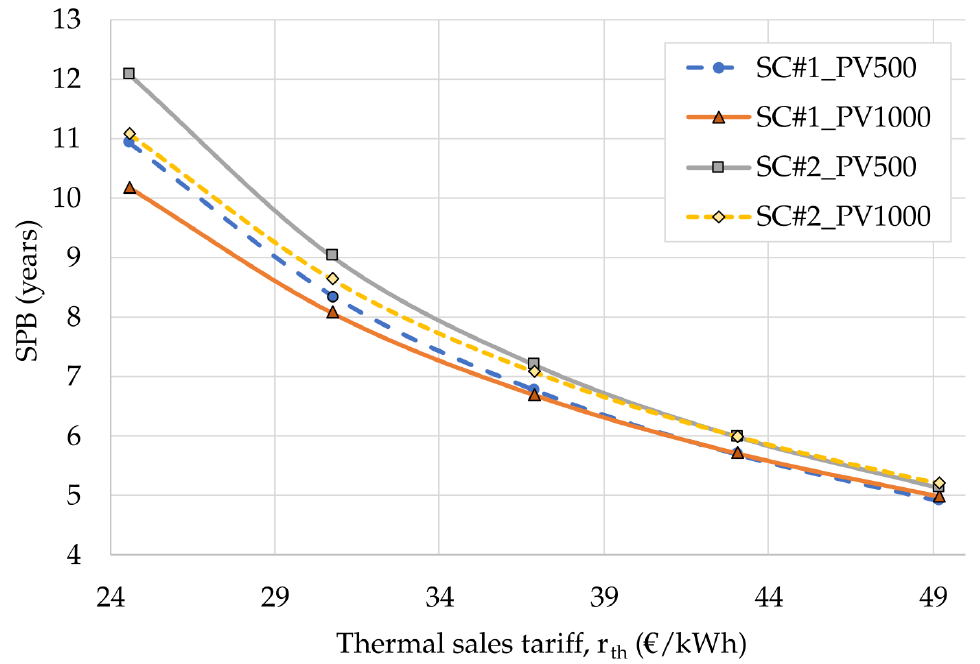
Figure 12. SPB for each REC scenario as a function of the tariff considered for the thermal energy delivered to the